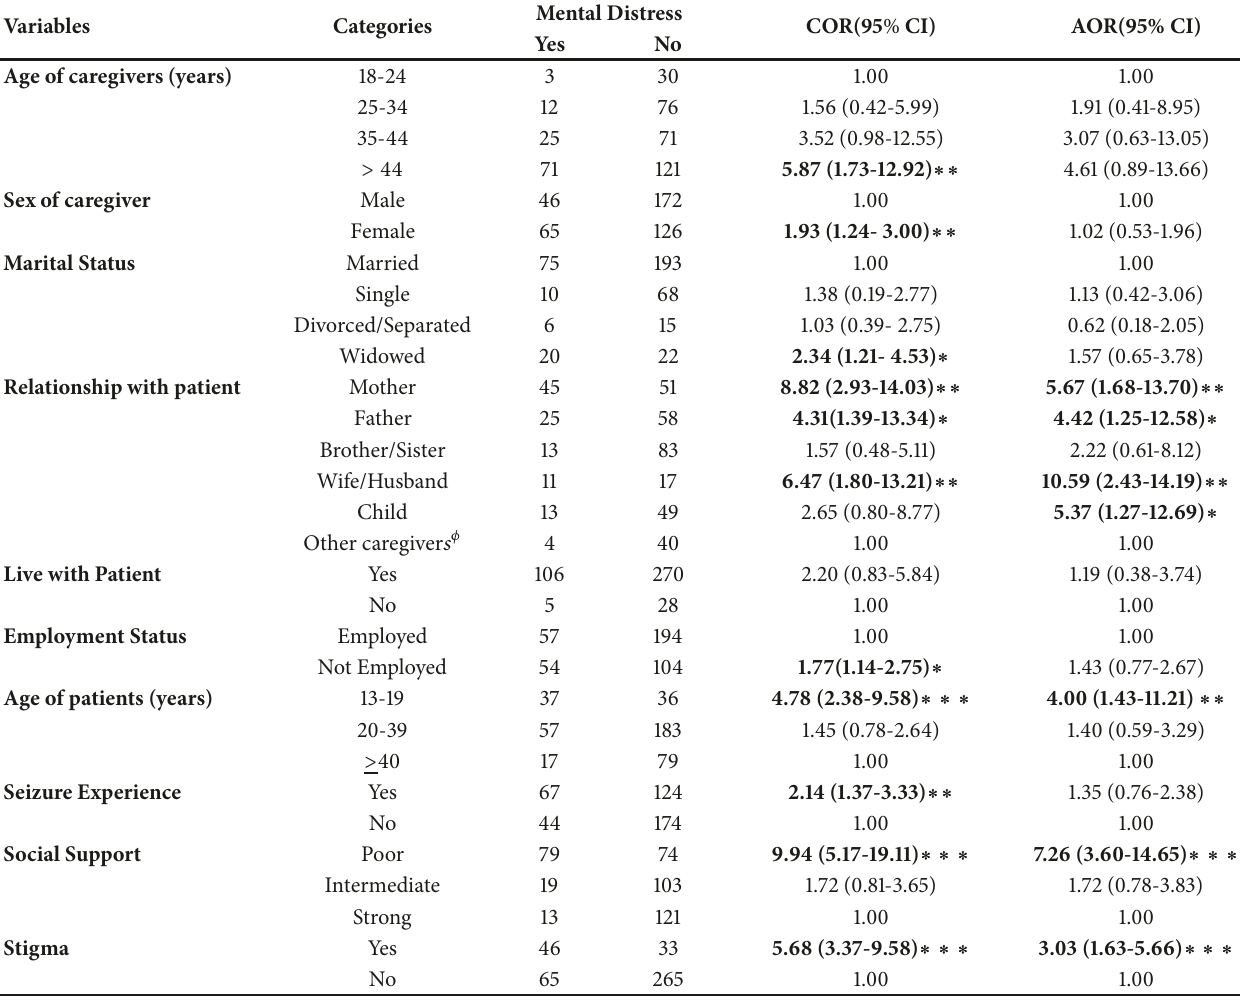
Table 4: Factors associated with mental distress among caregivers of patients with epilepsy at Amanuel Mental Specialized Hospital, Addis Ababa, Ethiopia, 2017